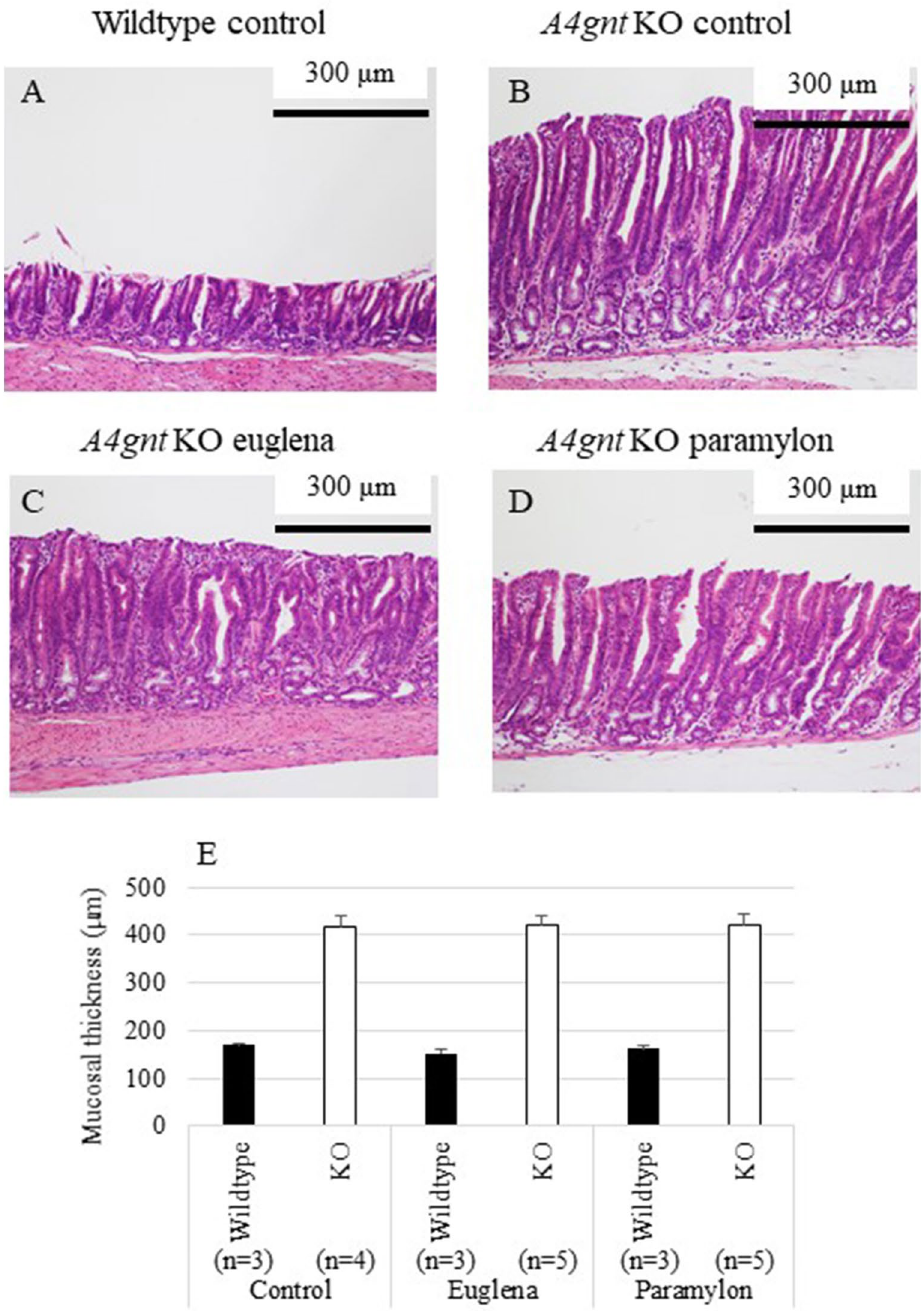
Figure 1. Histopathology of pyloric mucosa of A4gnt KO and wildtype mice. ( A ) Wildtype mouse administered saline. ( B ) A4gnt KO mouse administered saline. ( C ) A4gnt KO mouse administered 50 mg/day of Euglena . ( D ) A4gnt KO mouse administered 50 mg/day of paramylon. ( E ) Mean ± SD of thickness of pyloric mucosa. The mean thickness of gastric mucosa of 13-week-old A4gnt KO mice was significantly thicker compared with that of wildtype mice. Administration of Euglena and paramylon did not affect the thickness of the pyloric